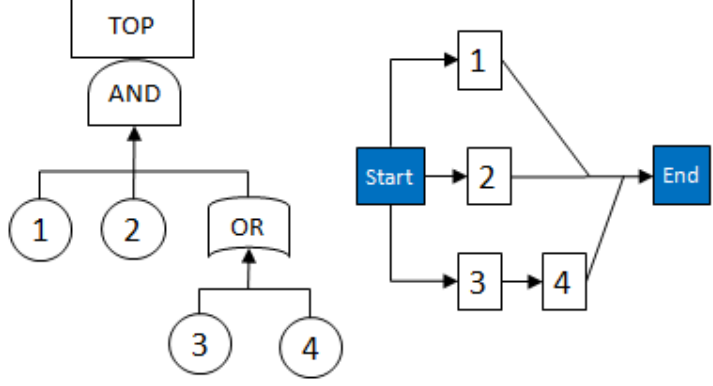
Figure 3. Example of a Fault Tree with equivalent Reliability Block Diagram (RBD).